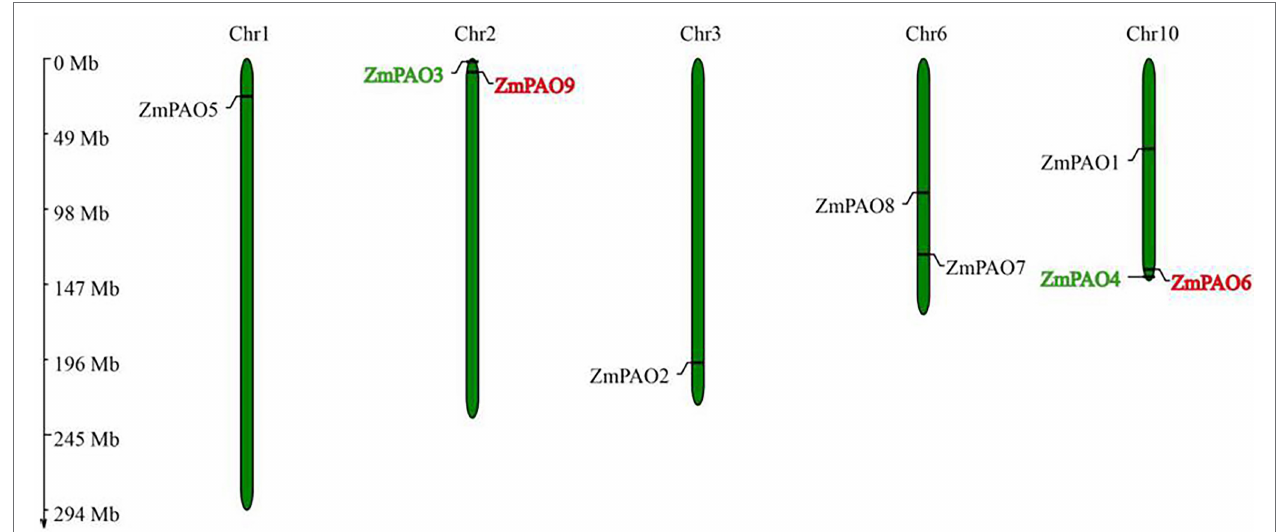
FIGURE 4 | Chromosomal location and gene duplication of the PAO gene family in maize. The gene names on each chromosome correspond to the approximate locations of each ZmPAO genes. Green and red gene names represent tandem duplicated gene pairs. The size of a chromosome is indicated by its relative length. The chromosome numbers are indicated at the top of each bar. The scale on the left is in